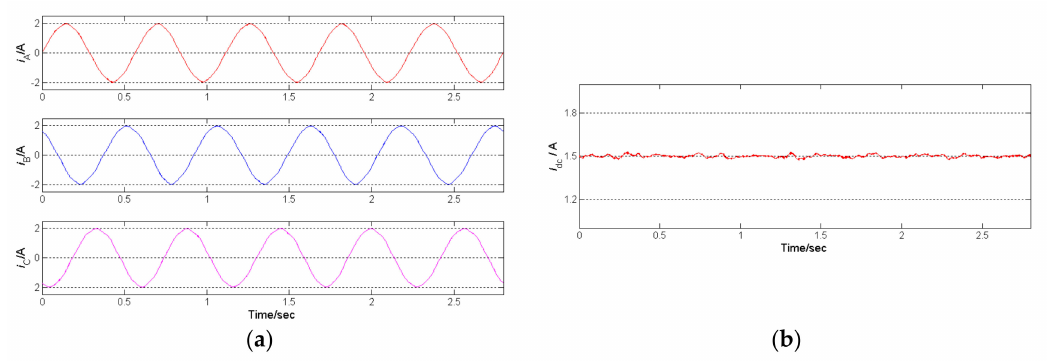
Figure 15. Current control results of i d = 0 control.